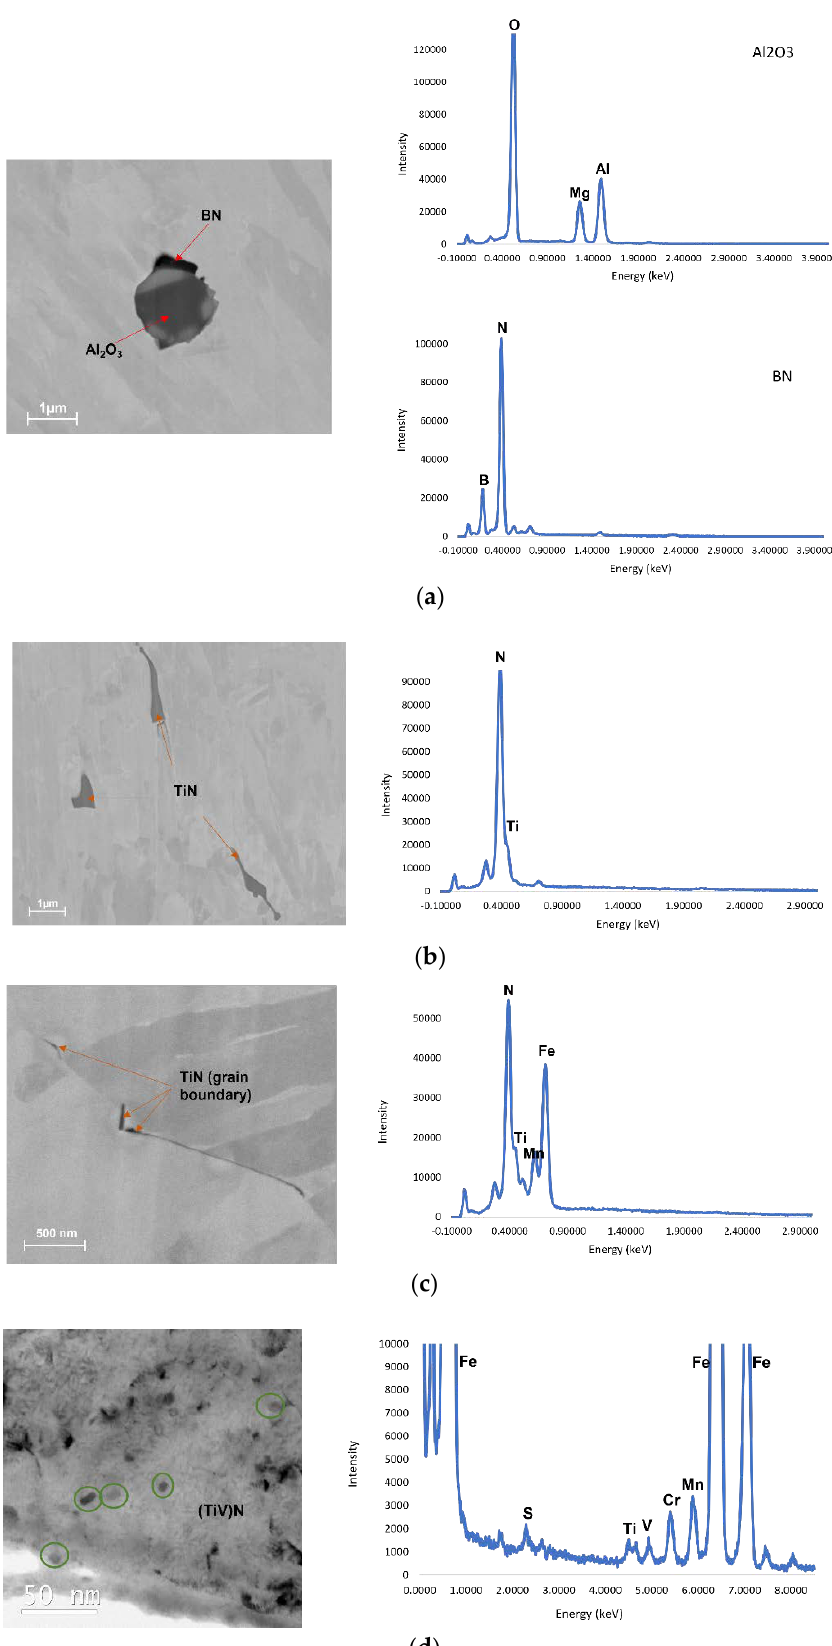
Figure 8. Precipitates in steel B: ( a ) BN at Al 2 O 3 ; ( b ) TiN in the matrix; ( c ) TiN at grain boundary; ( d ) complex (TiV)N.